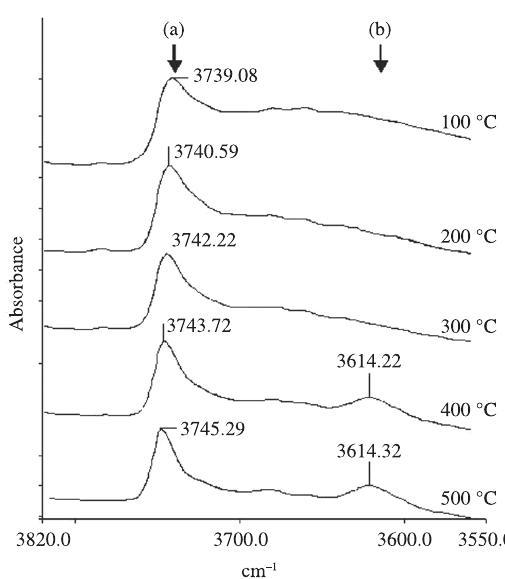
Figure 6. Reappearance of O-H stretching vibrations bands, with the increase of pyridine desorption temperature of zeolite sample HT560. a) Silanols (Si-OH) groups. b) Bridged Si-OH-Al